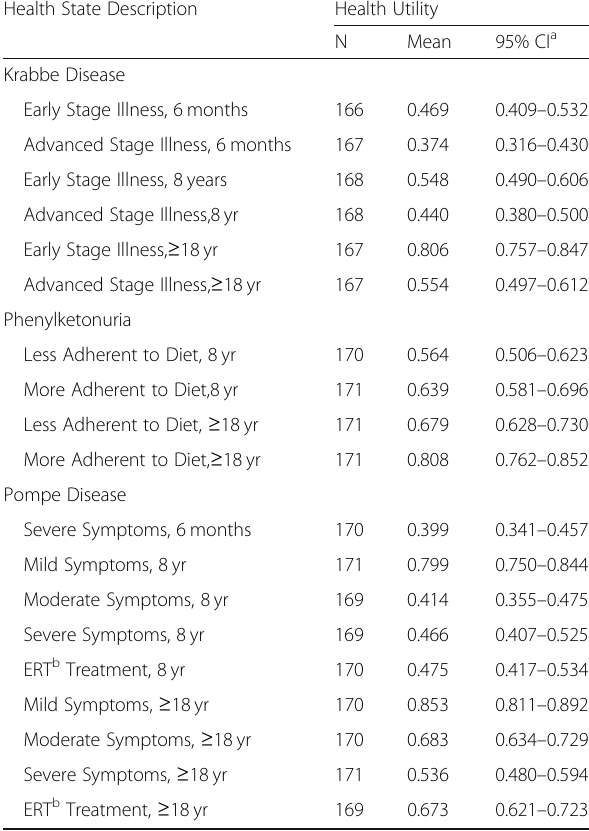
Table 2 Health utilities derived from a community sample by disease condition and age of patient